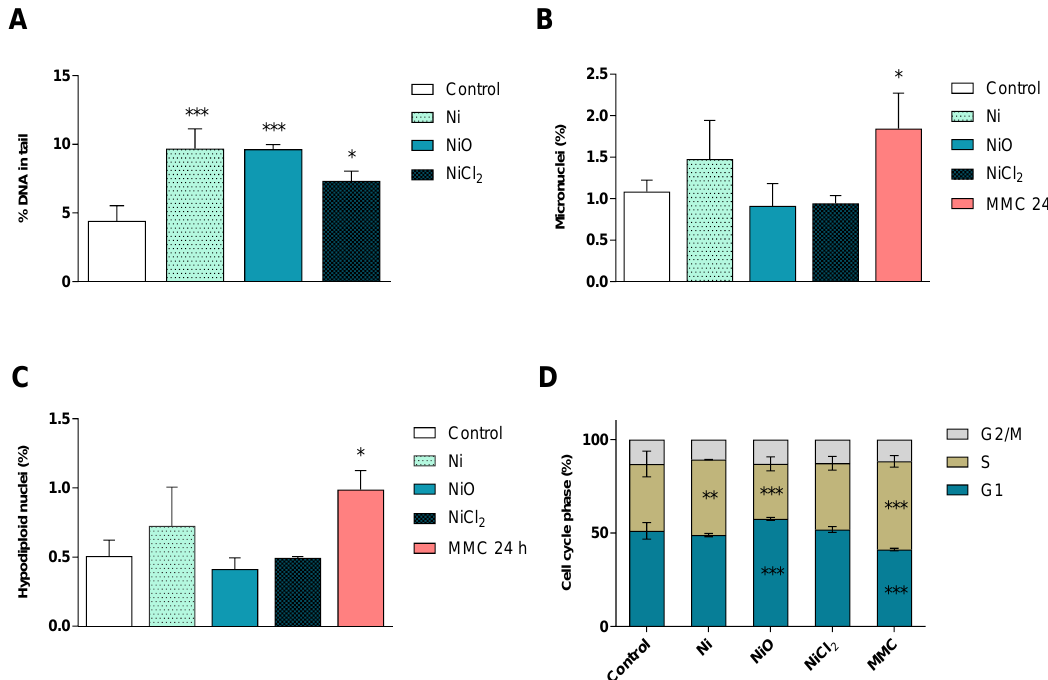
Figure 6. Genotoxicity and cell cycle analysis. ( A ) Induction of DNA strand breaks after six-week exposure was investigated using the alkaline comet assay. Results are expressed as % DNA in tail and presented as mean ± S.D. ( n = 3). ( B – C ) Micronuclei formation after six-week exposure was evaluated by flow cytometry. Results are expressed as percentage of micronuclei ( B ) and hypodiploid nuclei ( C ) and presented as mean values ± S.D. ( n = 3). ( D ) Cell cycle phase evaluation was performed by flow cytometry after 6 weeks of exposure. Results are presented as mean distribution (%) of the different cell cycle phases (G1, S, G2/M) ± S.D. ( n = 3). Positive controls: MMC 24 h, mytomycin C, 0.05 µg/mL 24 h. Significant results are marked with asterisks (* p -value < 0.05, ** p -value < 0.01, *** p -value < 0.001).